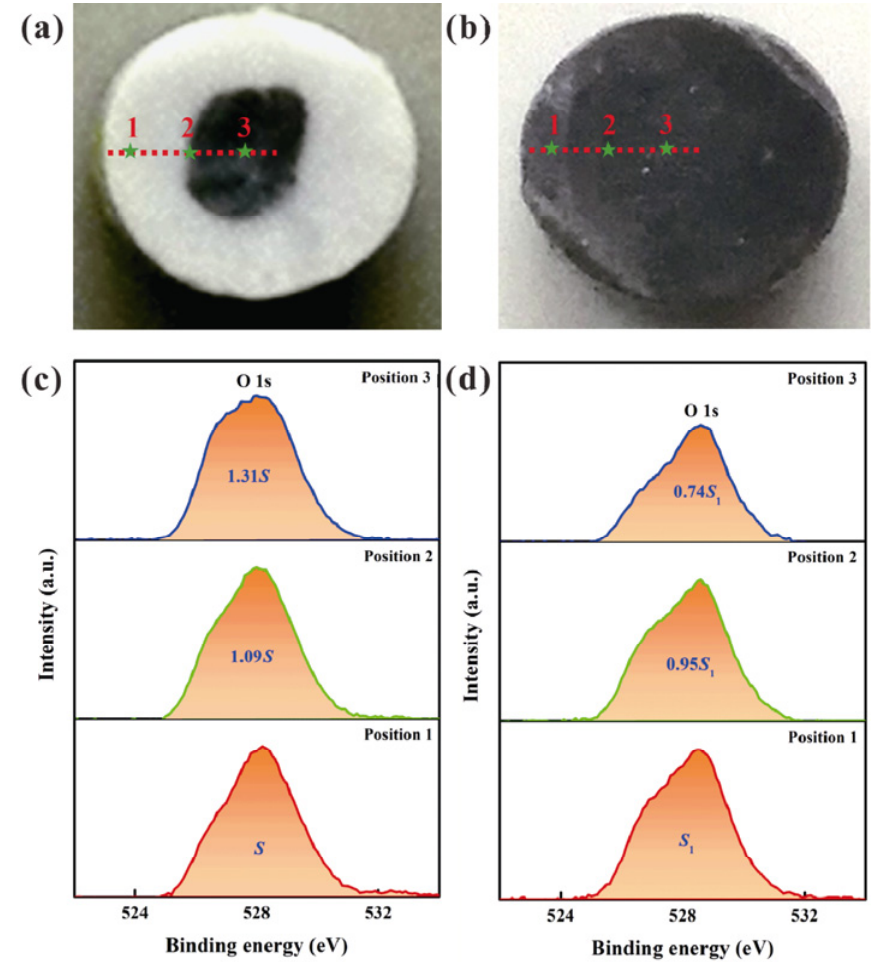
Fig. 4 XPS test samples and as-obtained O 1s spectra: (a) sample section annealed at 1200 for 4 h, (b) as ℃ -deposited sample section, (c) XPS results of the annealed sample, where S is the spectrum-peak area at Position 1, and (d) XPS results of the deposited sample, where S 1 is the spectrum-peak area at Position